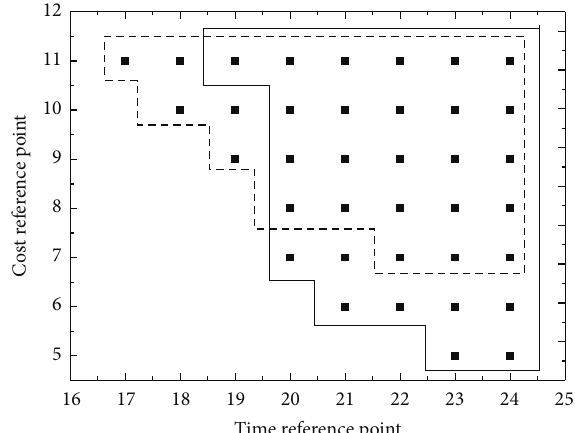
Figure 6: Possible reference points of carpooling success.